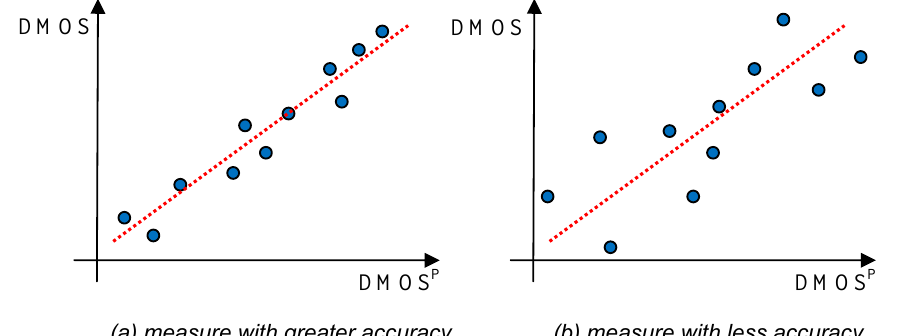
Figure 2 – Objective quality assessment metrics comparison through prediction